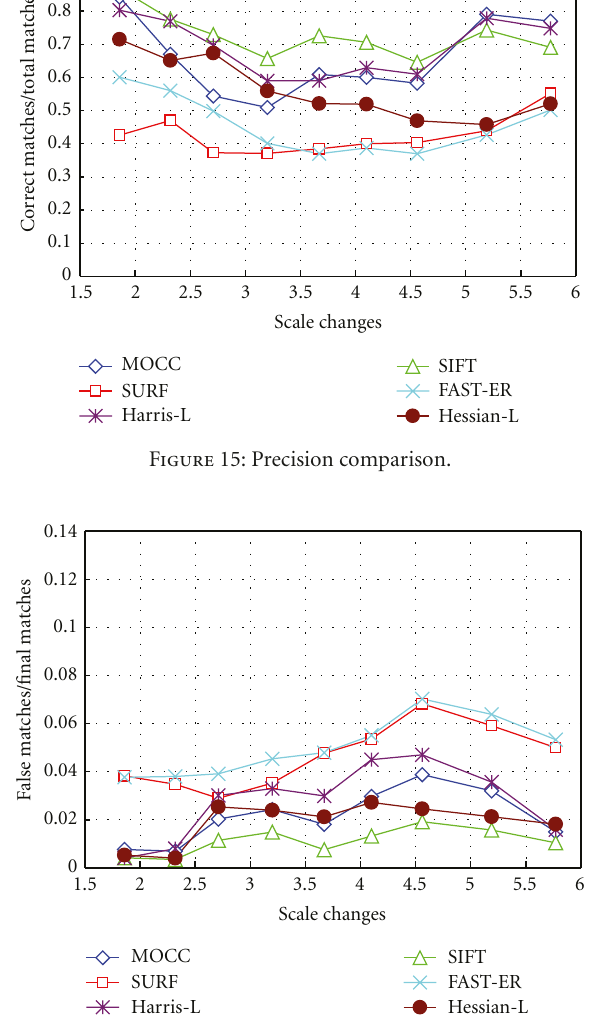
Figure 16: False match rate comparison.